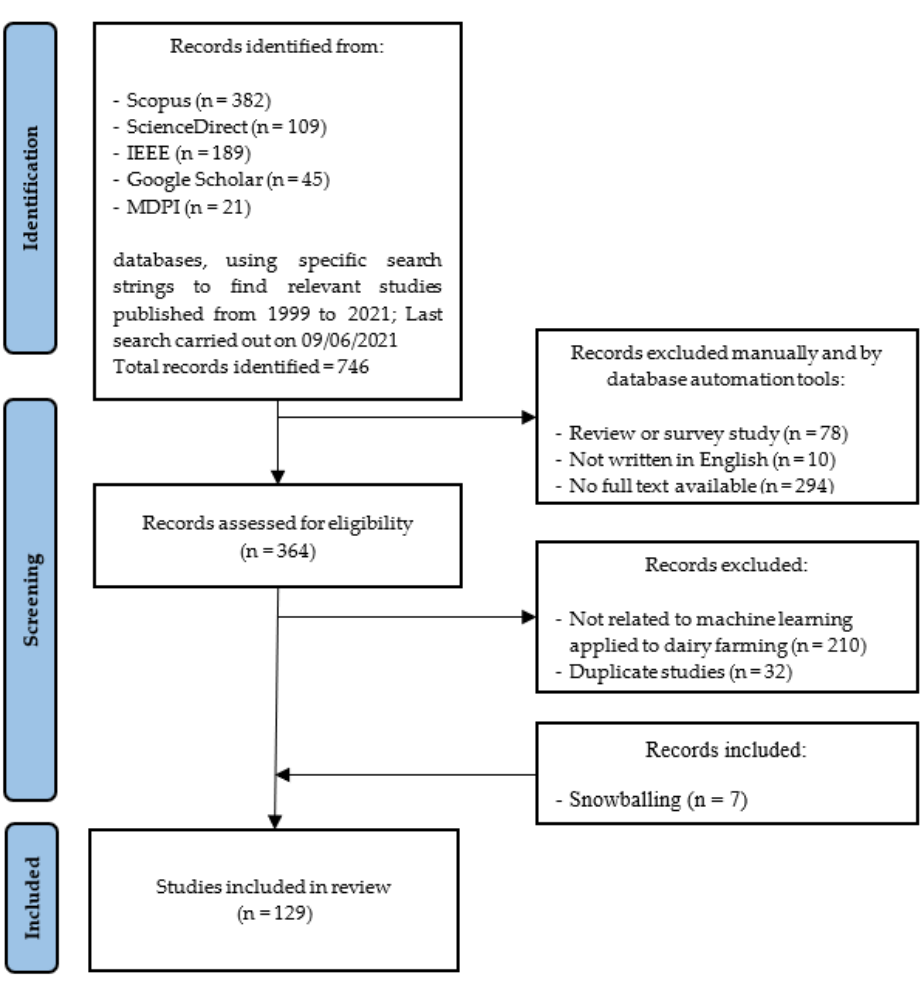
Figure 1. The flow of documents from identification to inclusion stage, in line with exclusion criteria.